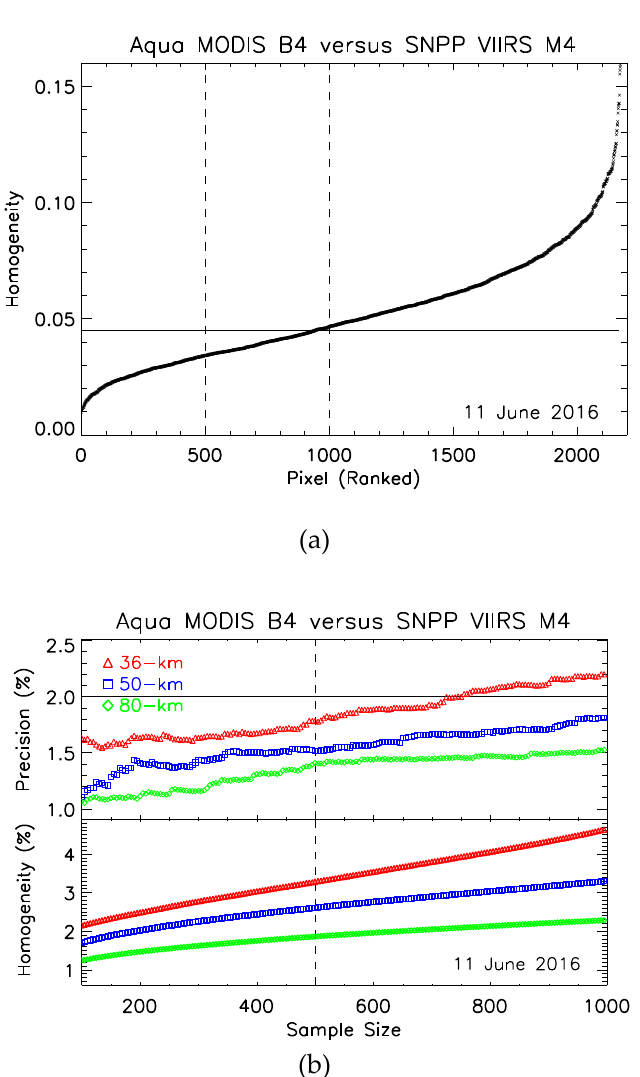
Figure 7. ( a ) Homogeneity versus ranked pixels for Aqua MODIS B4 versus SNPP VIIRS M4 for the 11 June 2016 SNO event and ( b ) precision (top panel) and homogeneity (bottom panel) with respect to sample size constraint for the 11 June 2016 event for the 36-km (red triangles), 50-km (blue squares), and 80-km (green diamonds) scales.